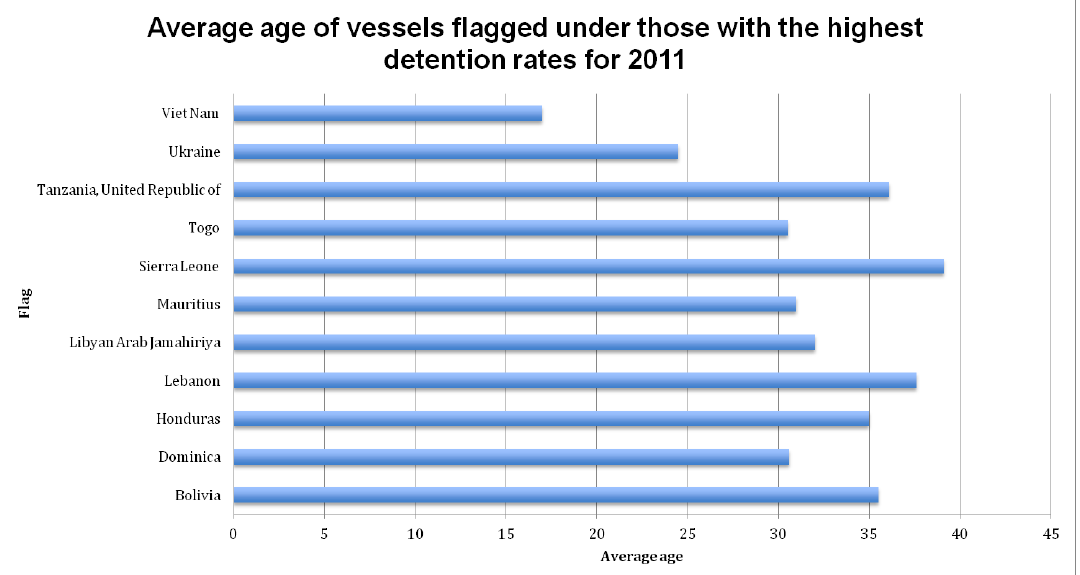
Graph 9C : Average age of vessels flagged under those with the highest detention rates for